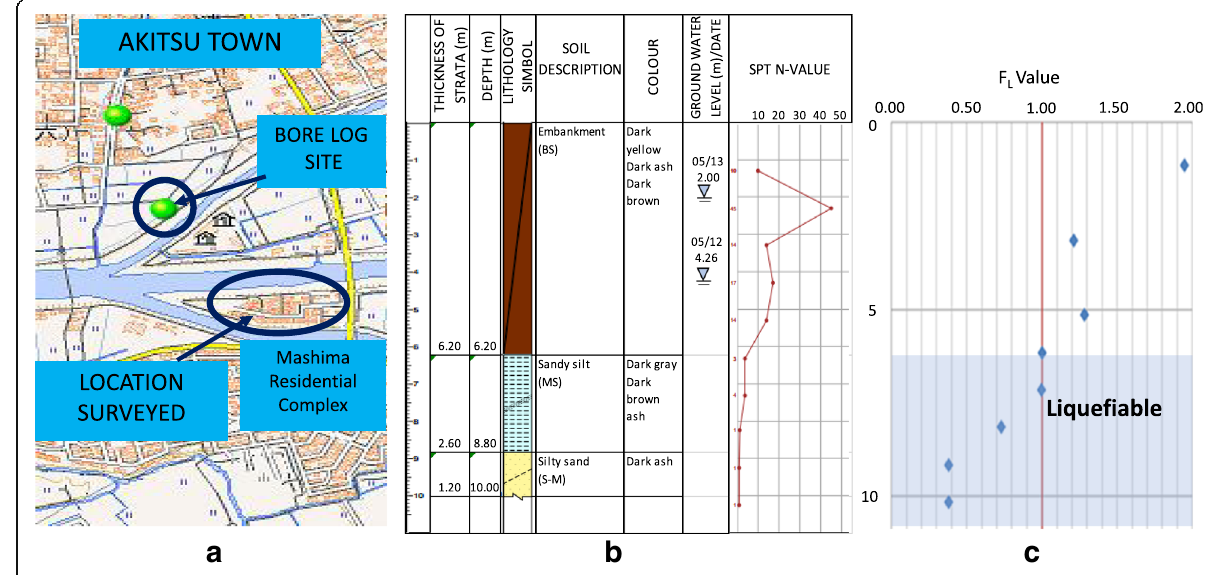
Fig. 7 a Bore log site in Akitsu; b Borehole data obtained in Akitsu; c FL values calculation result for Akitsu